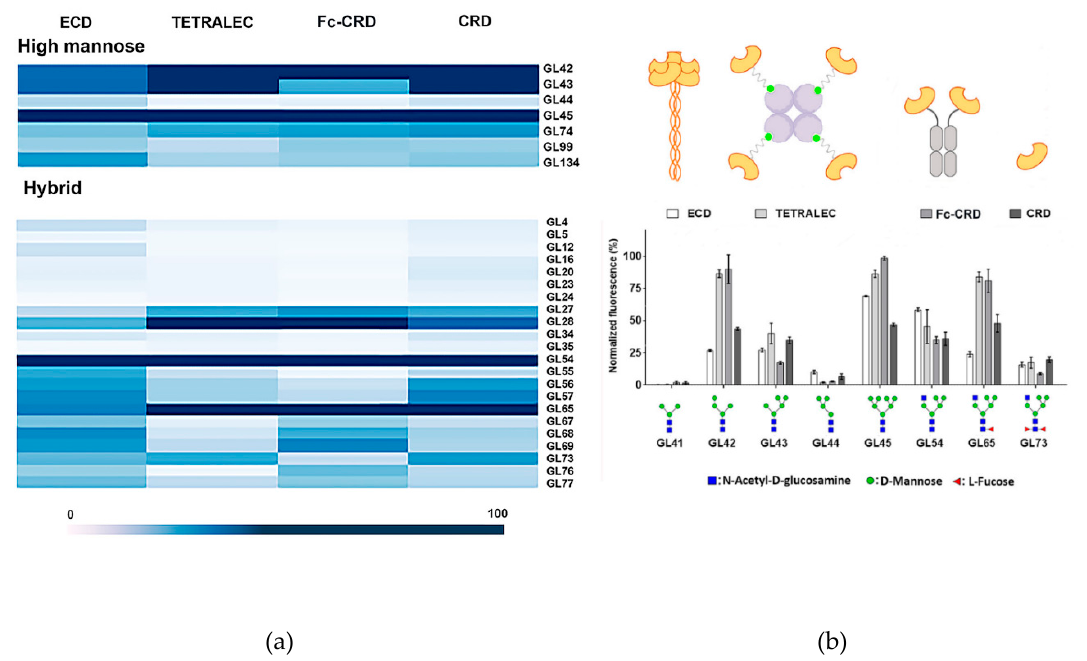
Figure 6. Glycan binding profiles of DC-SIGNR ECD, TETRALEC, Fc-CRD and CRD towards selected ligands. ( a ) High mannose and hybrid type N glycan structures were represented in a heat map classification. ( b ) Histograms representing the normalized fluorescence values.